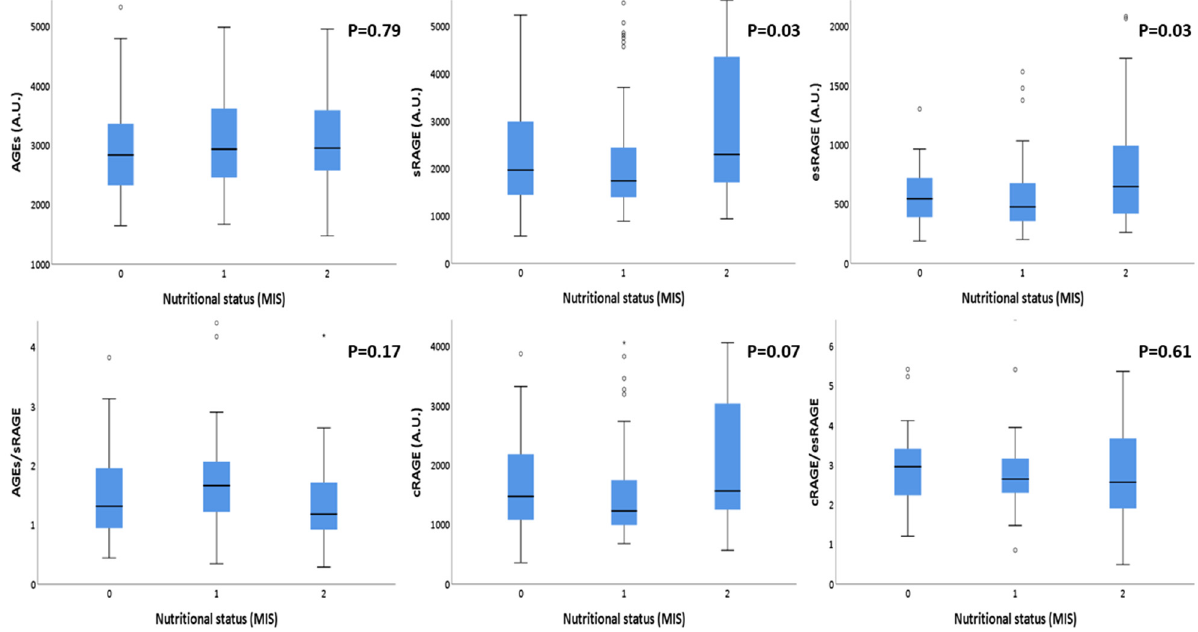
Figure 1. Box plot representation of AGEs, sRAGE isoforms’ distributions according to